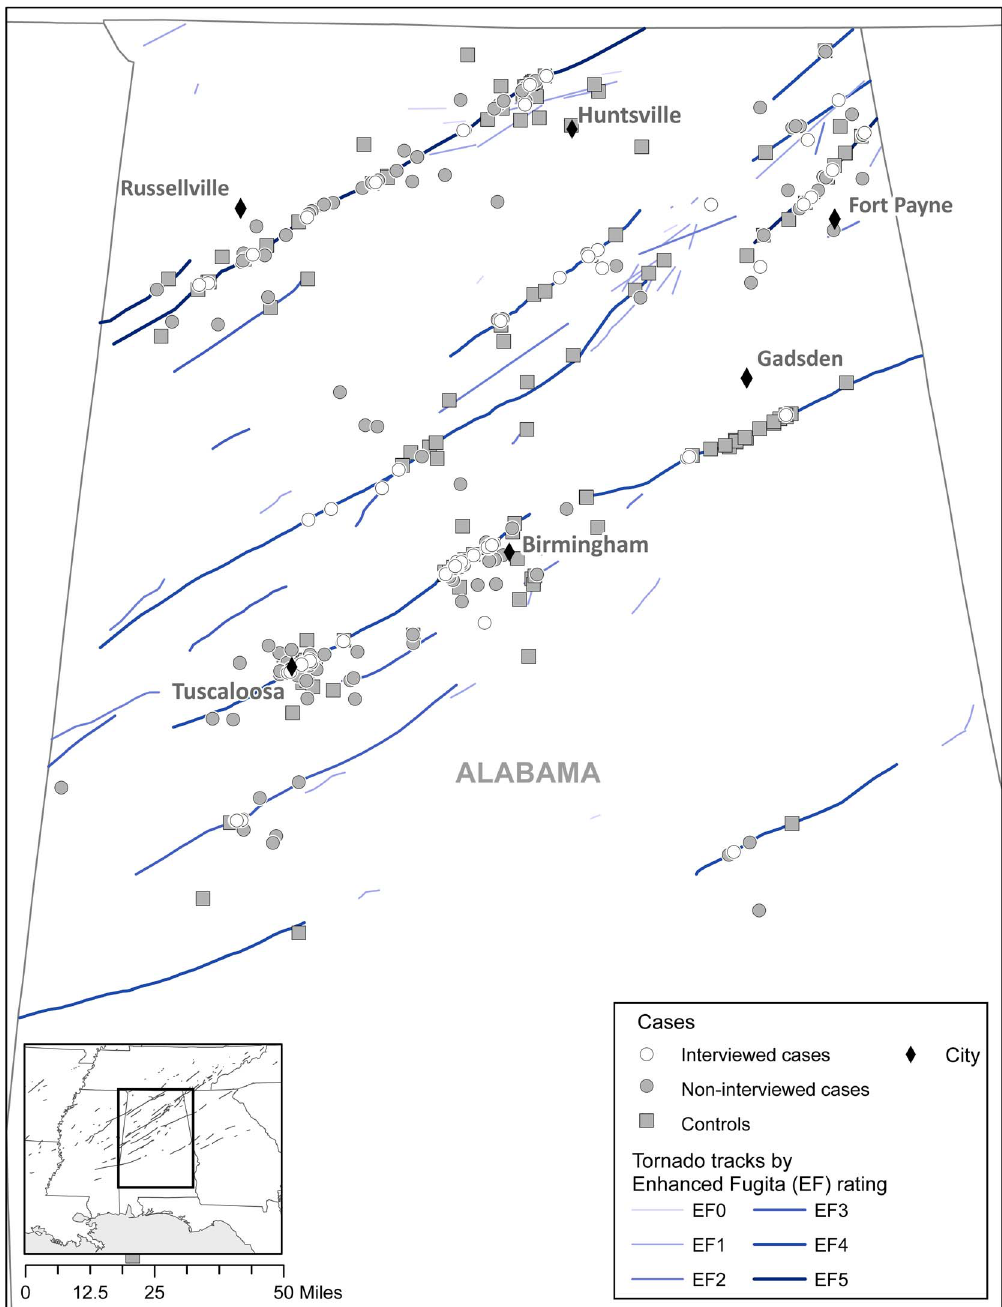
Figure 1. Geographic Information System (GIS) mapping of locations at the time of the tornado for 183 uninjured interviewed controls and 284 injured cases (including 73 interviewed cases and 211 non-interviewed patients with geocodable information in their hospital chart). A layer indicating the tornado paths was added. Most of the mapped cases (83.0%) and controls (83.3%) were closest to a violent EF 4–5 tornado path. EF tornado rating scale estimates the strongest wind gusts that occur 10 meters above the ground: EF-0 (65–85 mph [105–137 km/h]), EF-1 (86–110 mph [138–177 km/h]), EF-2 (111–135 mph [178–217 km/h]), EF-3 (136–165 mph [218–266 km/h]), EF-4 (166–200 mph [267–322 km/h]), and EF-5 ( . 200 mph [ . 322 km/h]).[1] doi:10.1371/journal.pone.0083038.g001 tornado after hearing tornado sirens was associated with lower odds the day of the event, seeking further information was associated of injury (aOR, 0.50; 95% CI, 0.28–0.90). Frequent estimated with lower odds of injury (aOR, 0.41; 95% CI, 0.18–0.93). annual tonado siren exposure ( . 5 times per year) was associated Sixty-six (22.1%) participants of the 298 surveyed patients with slightly lower odds of injury on the day of the event (aOR, screened positive for PTSD (Table 5). Death of a close person in 0.41, 95% CI, 0.17–0.99). Among the reactions to sirens shown on the tornado (aOR, 2.36; 95% CI, 1.22–4.54), loss of one’s home